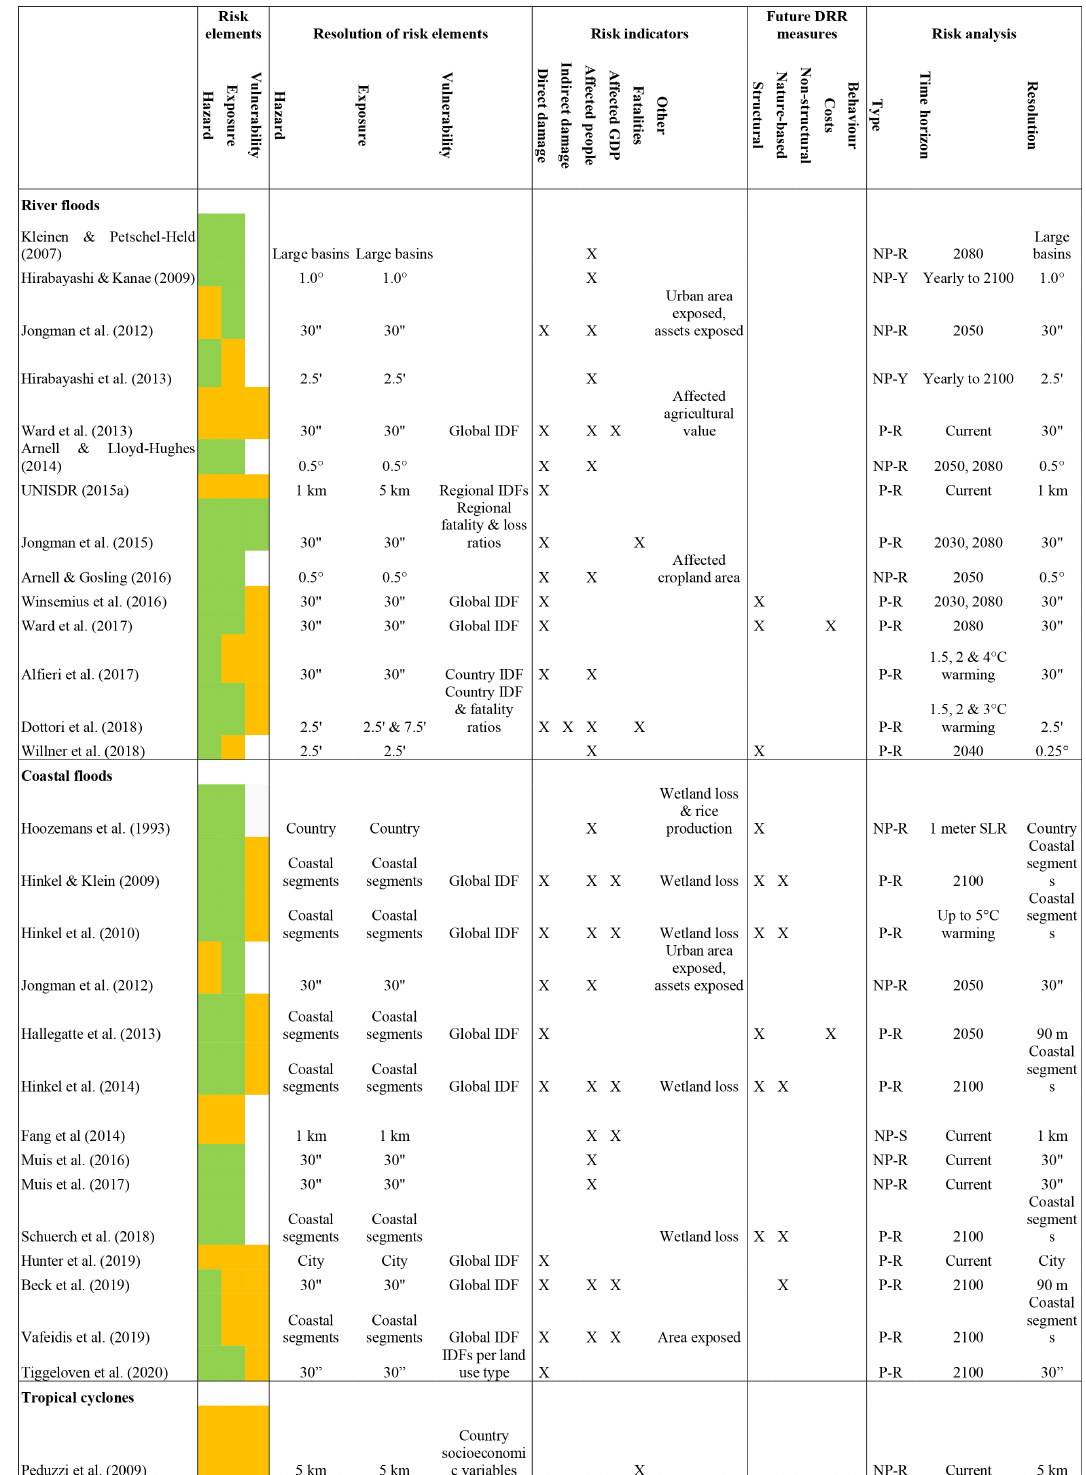
Table 1. Summary of findings across the reviewed literature and across the reviewed aspects. Explanatory notes: risk elements – white if this risk element is not included, orange if included and static, green if included and dynamic. Types of risk analysis are as follows. NP: non-probabilistic; P: probabilistic; S: stochastic event sets; RP: return period maps; Y: maps of yearly hazard; M: maps of monthly hazard; PE: past events; V: radius around specific volcano; IDF: intensity–damage